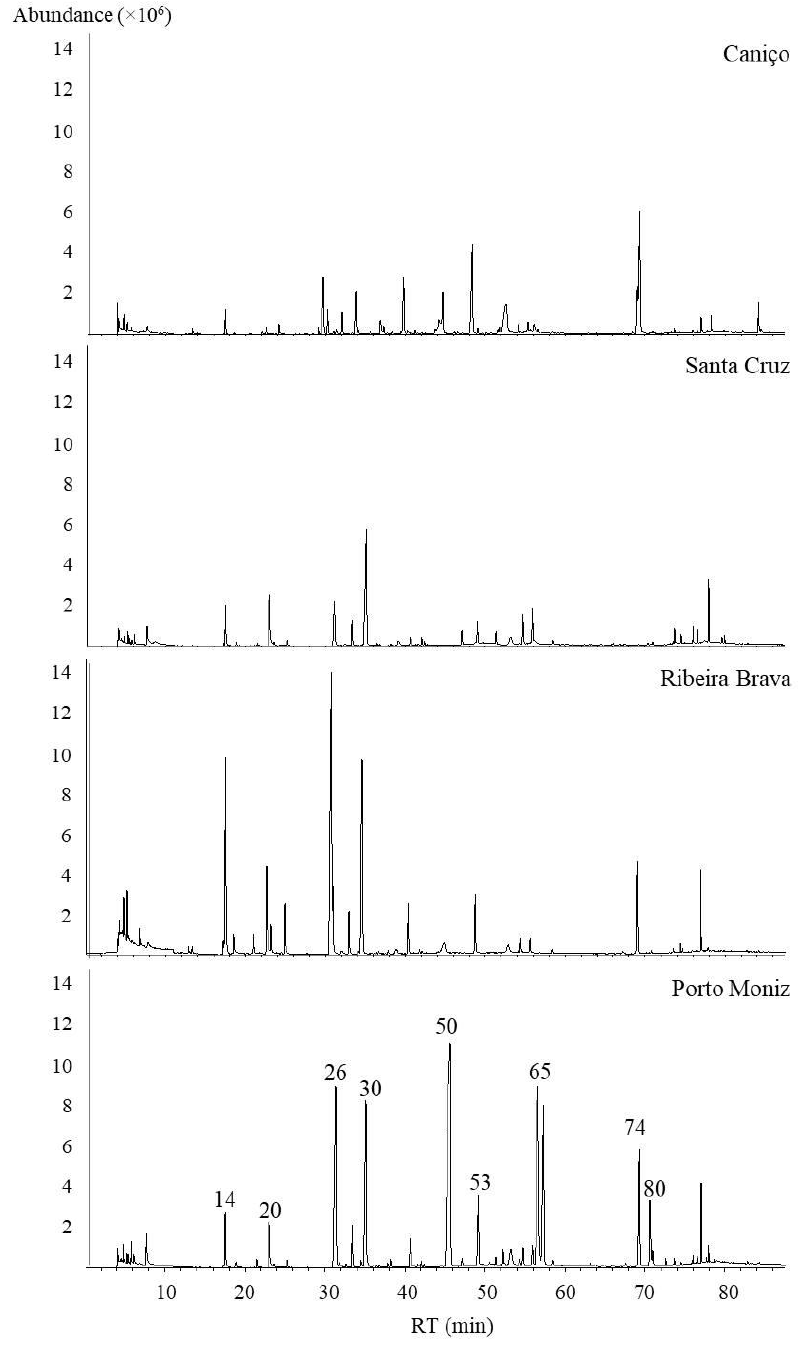
Figure 1. Total ion chromatograms obtained by HS-SPME/GC-qMS analysis of onions ( Allium cepa L.) from Spanish variety from different geographical regions of Madeira Island. Attribution of the peak number is shown in Table 2.